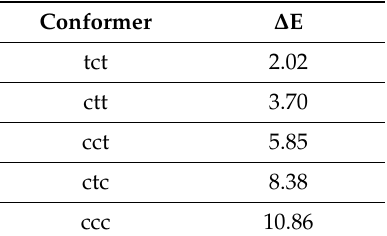
Figure A3. Ground state potential energy surface of the ctt and ttt conformers in which the dh1 dihedral angle (1-2-3-4, see Figure 1) is rotated from 0° to 180° while the rest of the backbone is kept constant (B3LYP/cc-pVDZ data). The trajectories of cct, ccc and ctc are identical to the one of ctt and are therefore not depicted by a color code. 012 34 56 7 0